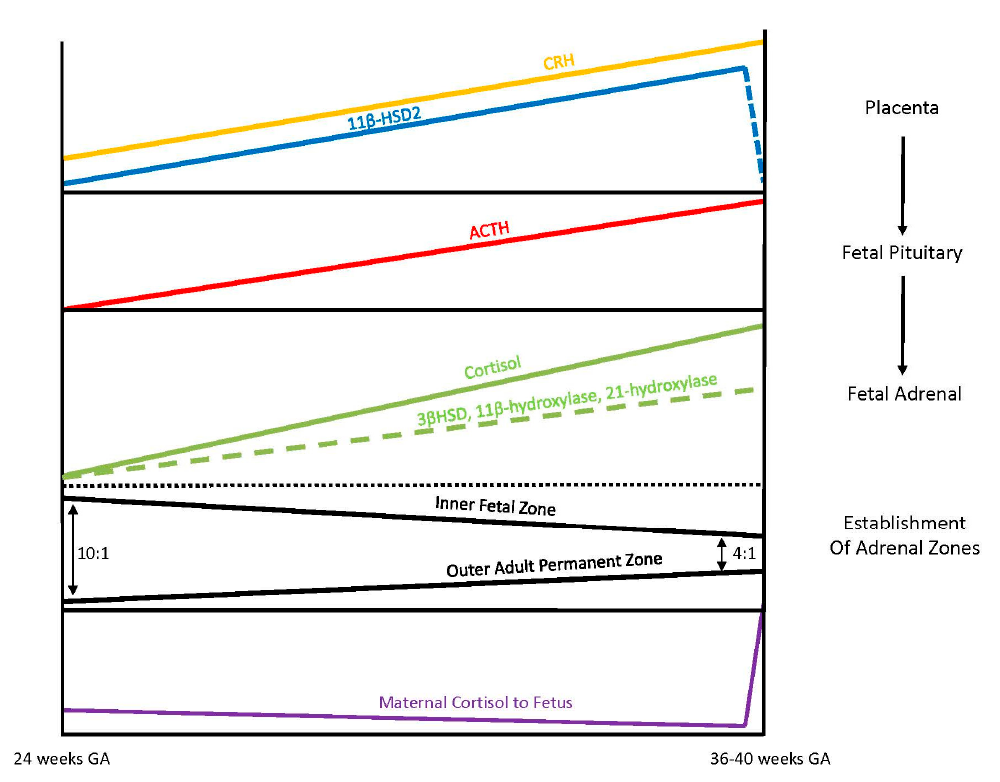
Figure 3. Dynamic changes of the fetal hypothalamic-pituitary-adrenal axis. During the third trimester, 24 to 36–40 weeks of gestation, the placenta increases production of corticotropin-releasing hormone (CRH). In response to placental CRH, production of adrenocorticotropic hormone (ACTH) by the fetal pituitary accelerates and stimulates the fetal adrenal to undergo steroidogenesis for cortisol production. Required enzymes for cortisol production within the adrenal, 3 β - hydroxysteroid dehydrogenase (3 β HSD), 21-hydroxylase (P450c21), 11 β -hydroxylase, are activated. The establishment of the outer adult permanent zone of the adrenal also occurs during the third trimester. During the third trimester, activity of 11 β -hydroxysteroid dehydrogenase 2 (11 β -HSD2) within the placenta also increases and thereby exposure of the fetus to maternal cortisol remains low until the surge right before